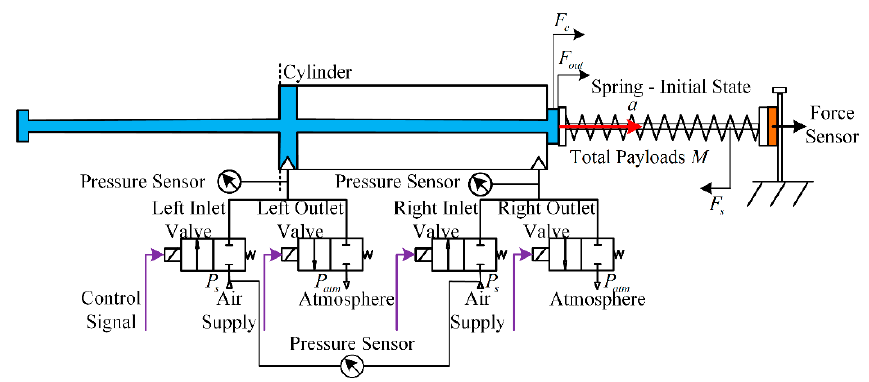
Figure 9. Schematic diagram of the force tracking system.